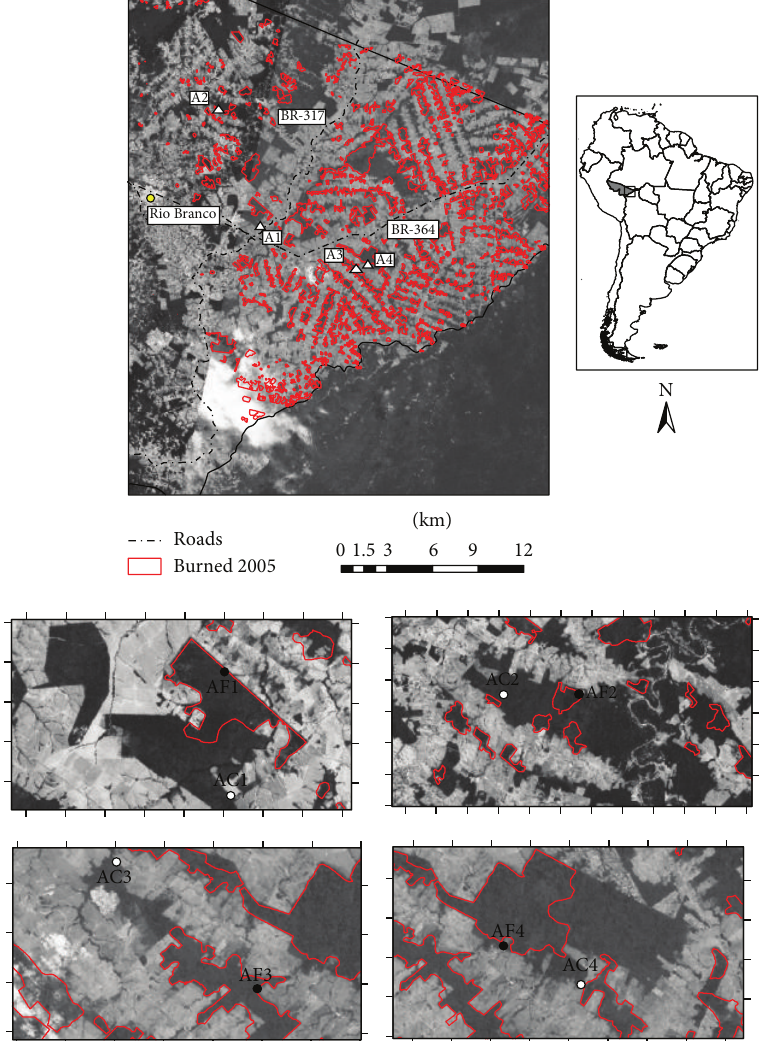
Figure 1: Eastern Acre, Brazil (F1). The sites outlined in red were burned in 2005. The triangles indicate the location of the four study sites (A1, A2, A3, and A4) within the study area (Table 1), and in the more detailed maps (F2–F5), the circles ( I ) represent the control sites (AC1– AC4), and the squares ( ◻ ) represent the sites burned in 2005. The dark areas in the map represent the existing vegetation and the clear areas represent the anthropogenic